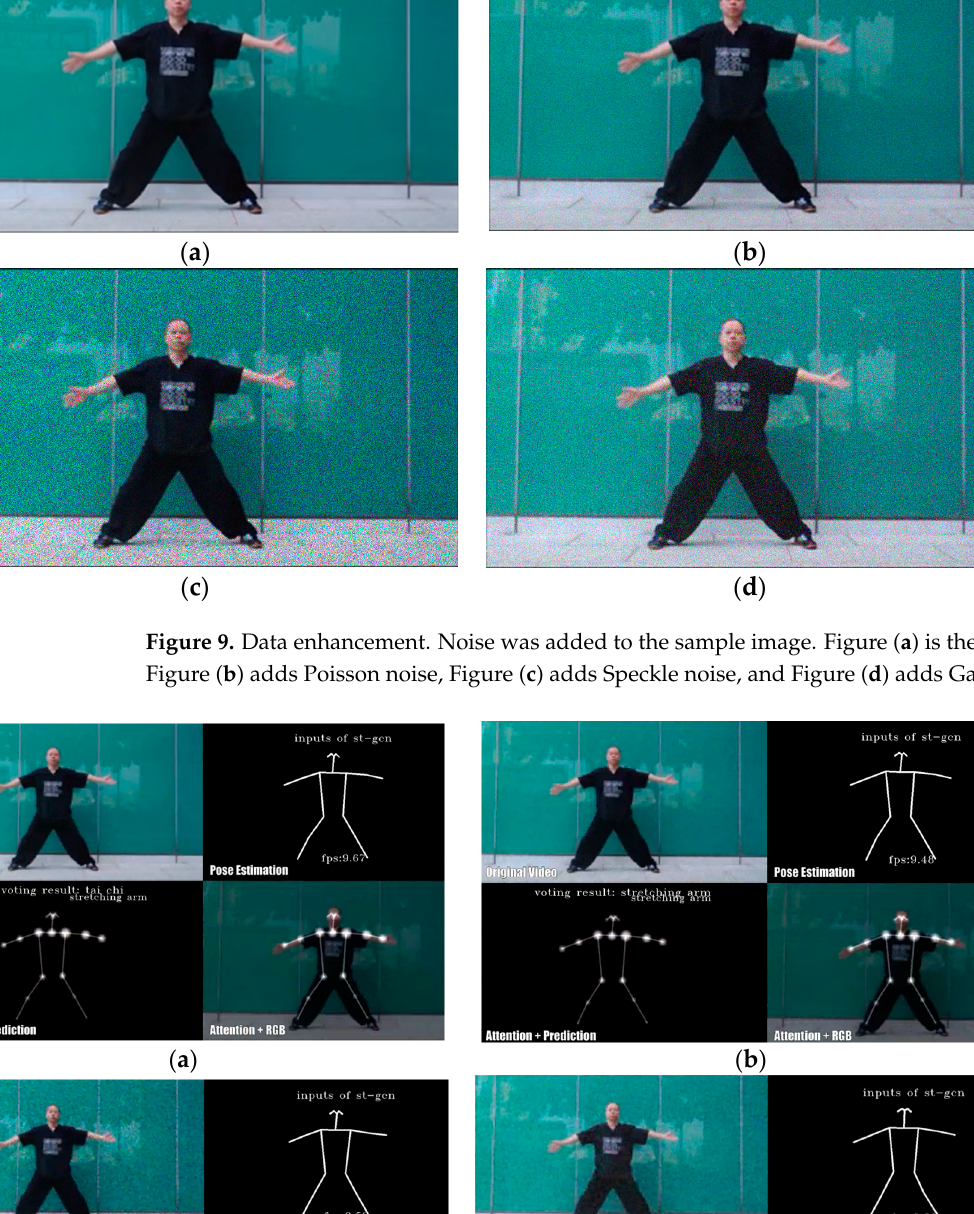
Figure 10. NEW-STGCN-CA recognition effect of noise sample image. Figure ( a ) is the original image, Figure ( b ) adds Poisson noise, Figure ( c ) adds Speckle noise, and Figure ( d ) adds Gaussian noise.